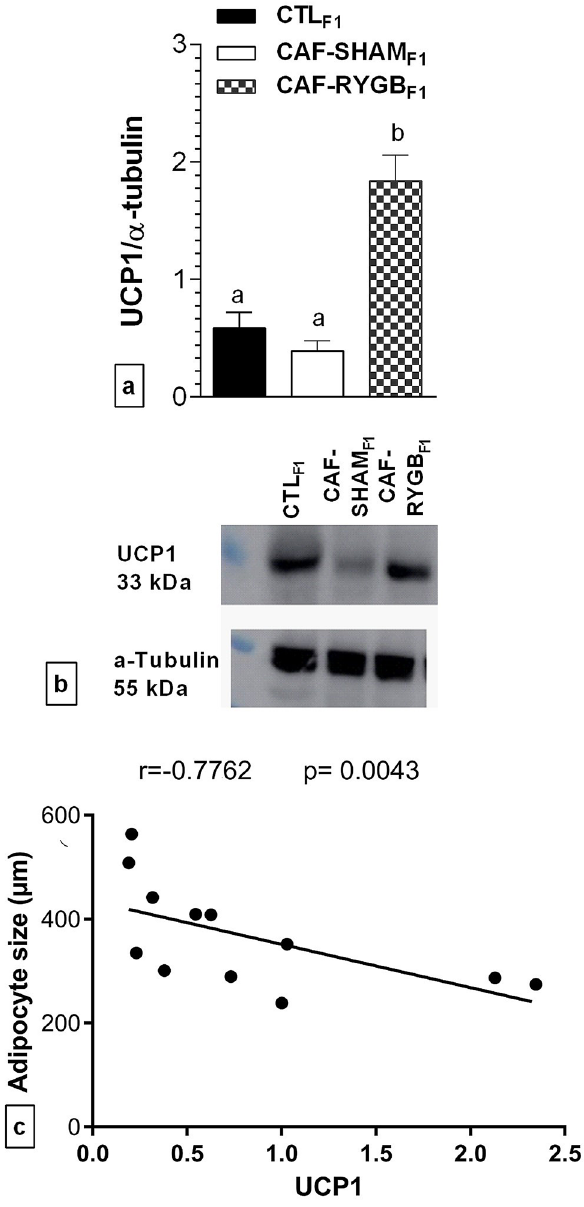
Figure 5. Effect of maternal obesity and RYGB on UCP1 expression in BAT of adult male offspring. CTL F1 , offspring of rats fed standard diet; CAF-SHAM F1 , offspring of rats fed on CAF diet and submitted to sham operation; CAF-RYGB F1 , offspring of rats fed on CAF diet and submitted to RYGB (n = 4 animals/group). UCP1 expression ( a ), was analysed by Western Blot, normalized by α tubulin protein expression ( b ), and correlated UCP1 expression with adipocyte size ( c ). Data are represented as means ± SEM. Different letters indicate statistical differences by one-way ANOVA and Bonferroni post-test ( p < 0.05). UCP1, uncoupling protein 1. Correlation was analysed using nonparametric Spearman’s test. p values less than 0.05 were considered significant. Uncropped images in supplementary